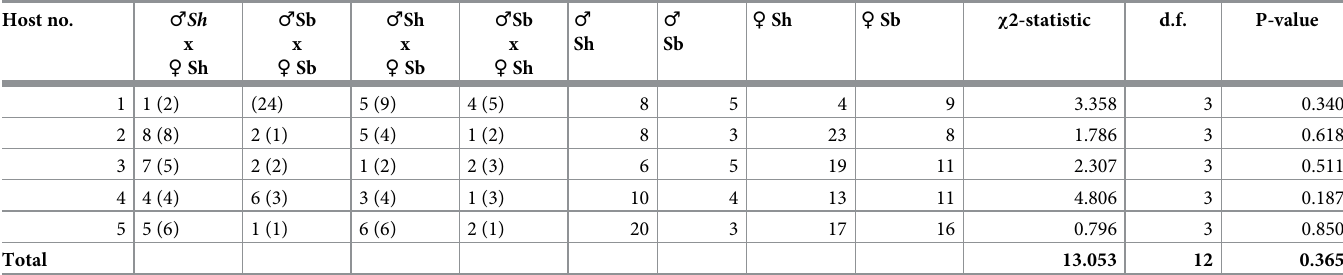
Table 3. Summarized information of experiment 5 (full choice). For each combination ( i . e .,sex and species) are given the number of observed pairs and the number of single partners that remained single. Sh = S . haematobium and Sb = S . bovis . Expected number of pairs under random mating is shown in brackets (see the statistics section in Materials and Methods for details). Chi squared statistics, degree of freedom and P-value are given per hamster and for the whole experiment. Host